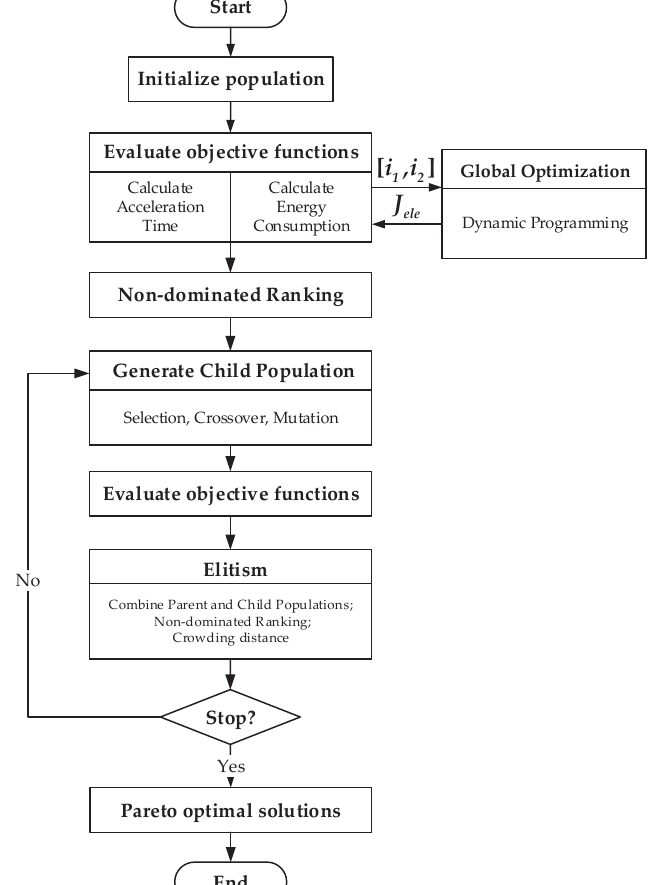
Figure 2. Flowchart of the gear ratio optimization procedure with the Nondominated sorting genetic algorithm-II (NSGA-II)